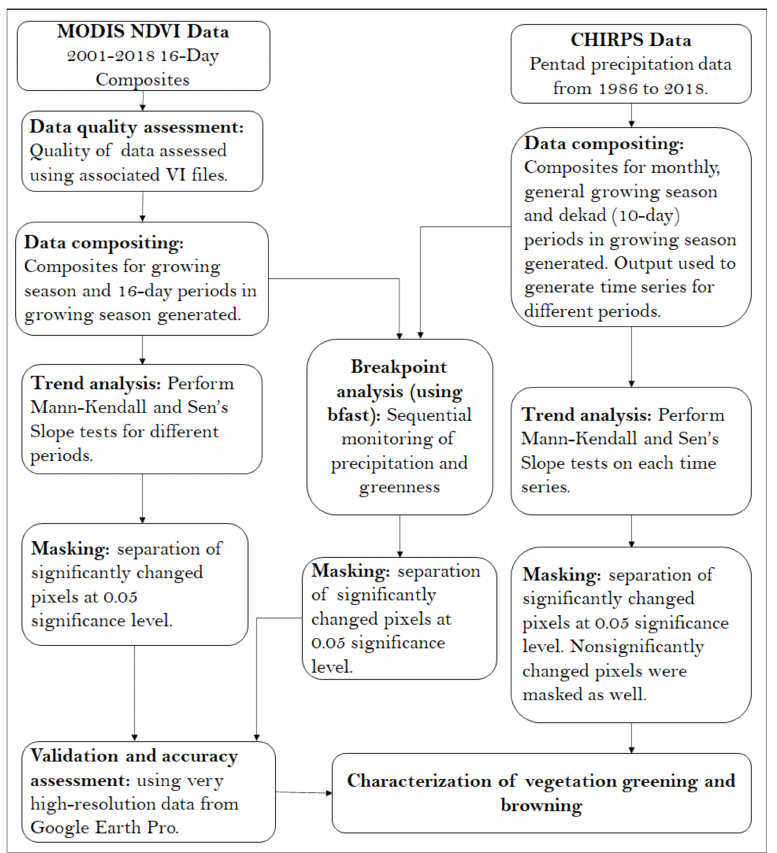
Figure 3. Flowchart of analysis methods used in the